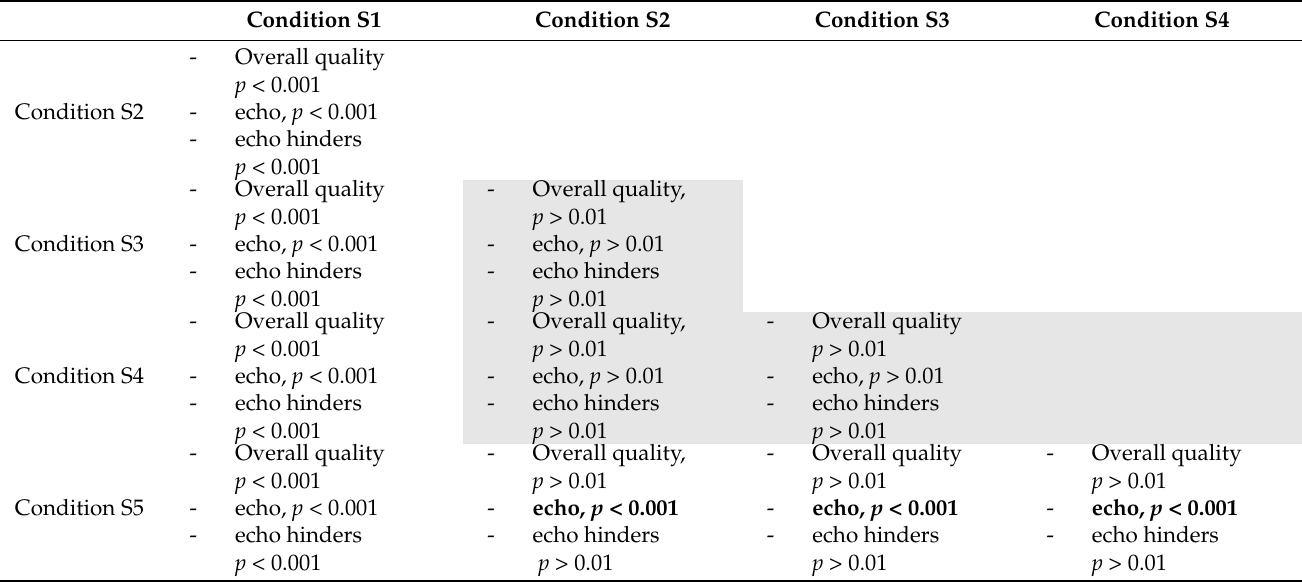
Table A3. Comparison Matrix between the Five Student Conditions